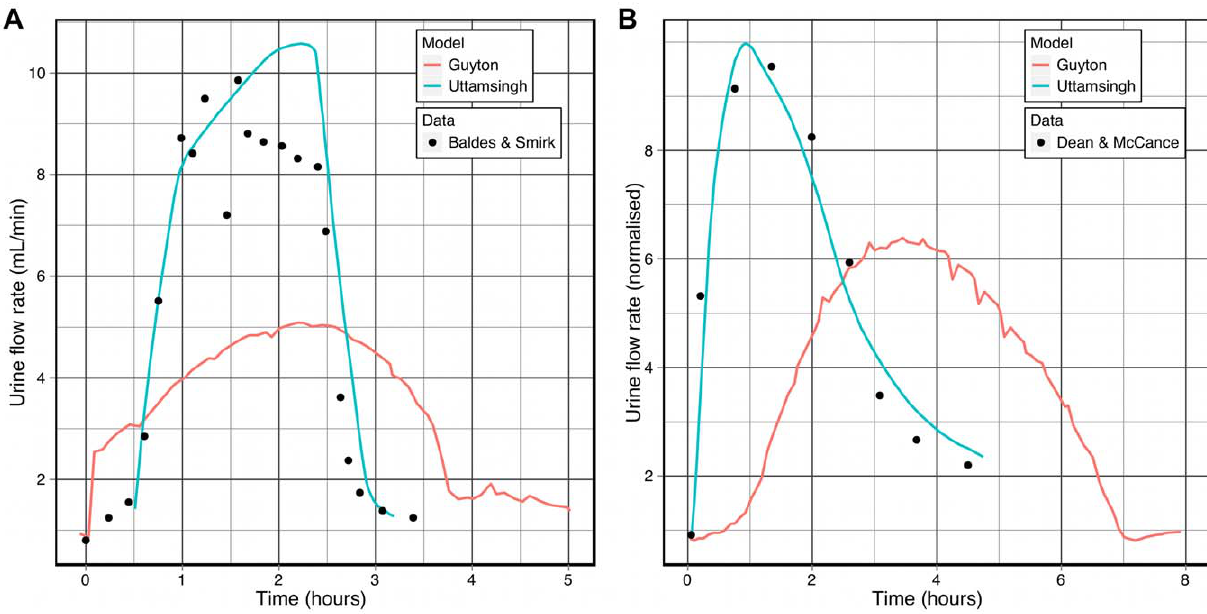
Figure 9. The effects of ingestion of hypotonic and hypertonic solutions on urine flow. These simulations reproduced the conditions shown in Figures 3 and 4 of Uttamsingh et al. [74], which include experimental from Baldes and Smirk [93] and Dean and McCance [75]. A: Urine flow following ingestion of 1 L of water. B: Urine flow following ingestion of hypertonic saline (normalized wrt. the urine flow rate prior to ingestion).